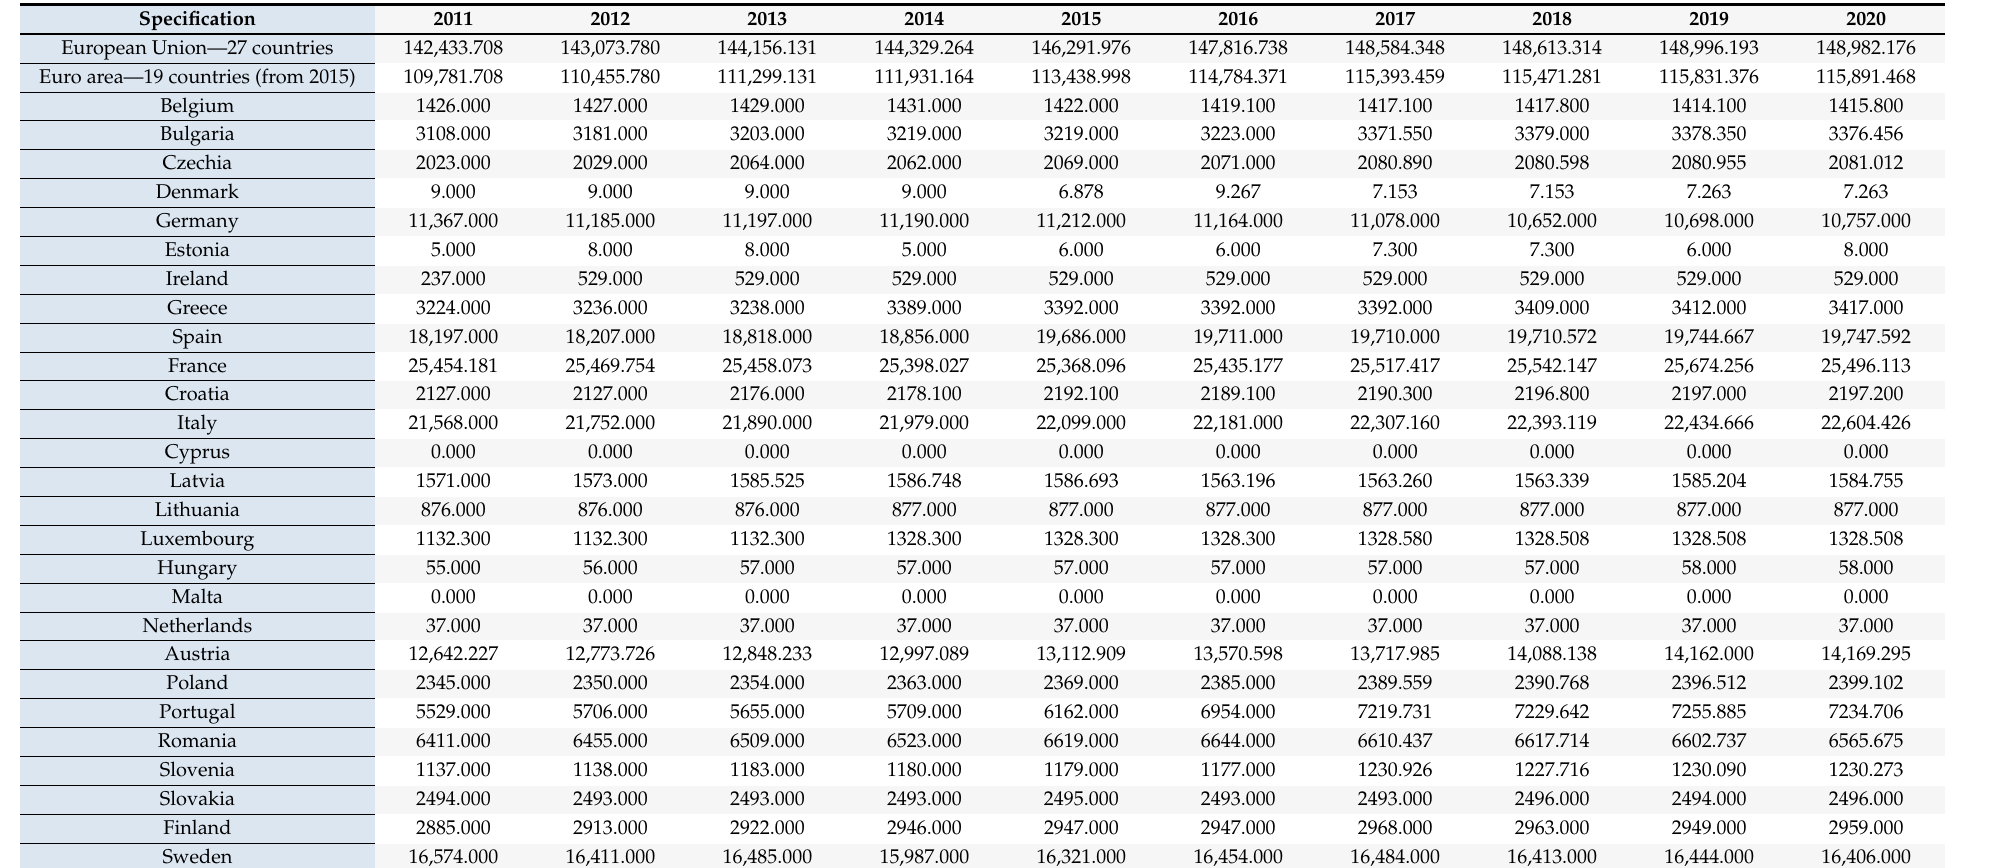
Table 1. Hydropower electricity production capacities in EU countries (in MW)